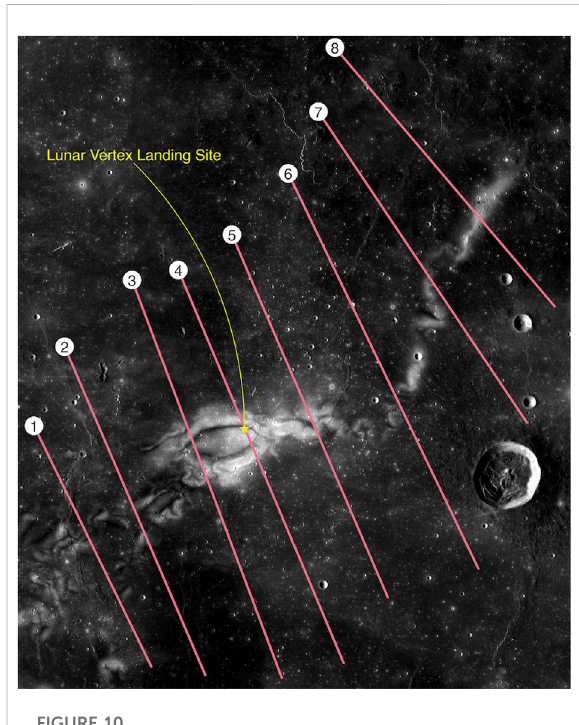
FIGURE 10 Reiner Gamma from LROC WAC 100 m/pixel global morphologic basemap (I/F stretch: 0.017 to 0.037) with cross- anomaly pink pro fi les at 8 locations that exhibit different weatheringsignatures,fromwhichsampleswereextractedin multiple wavelengths and ratios. The LVx landing site (7.585 ° N, 58.725 ° W) is indicated by a yellow star on pro fi le